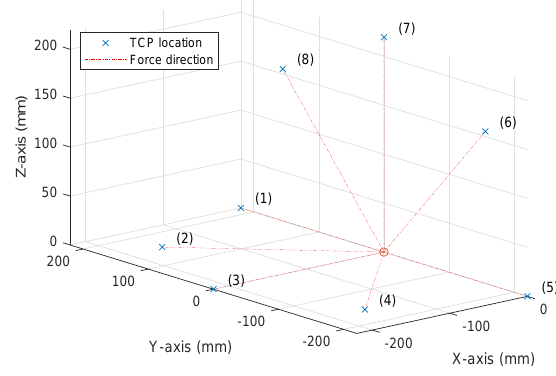
Figure 12: 6-DOF Industrial Robot: TCP location dur- ing tests with 220 mm pneumatic cylinder.